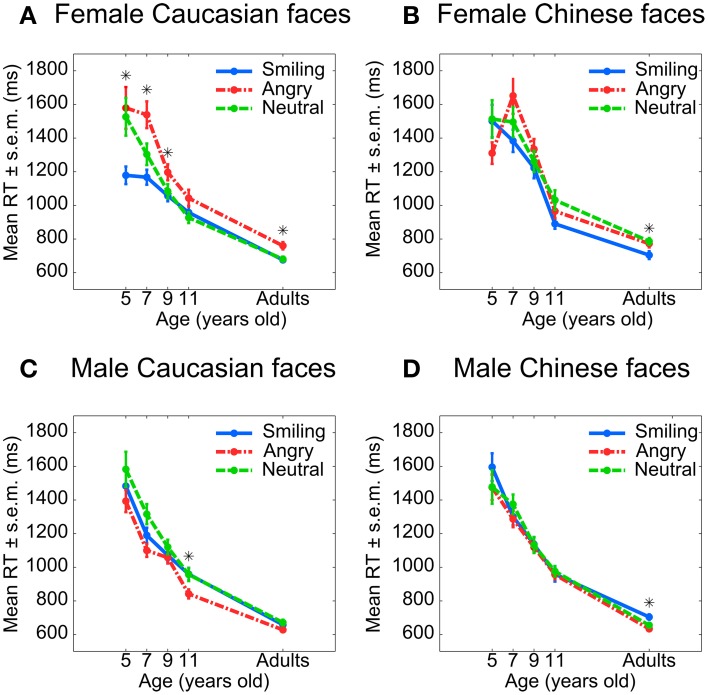
Reaction times for gender categorization in Experiments 1 (adults) and 2 (children). Only reaction times from correct trials are included. Each star represents a significant difference between angry and smiling faces (paired Student t-tests, p < 0.05, uncorrected). Top: Caucasian (A) and Chinese (B) female faces. Bottom: Caucasian (C) and Chinese (D) male faces.